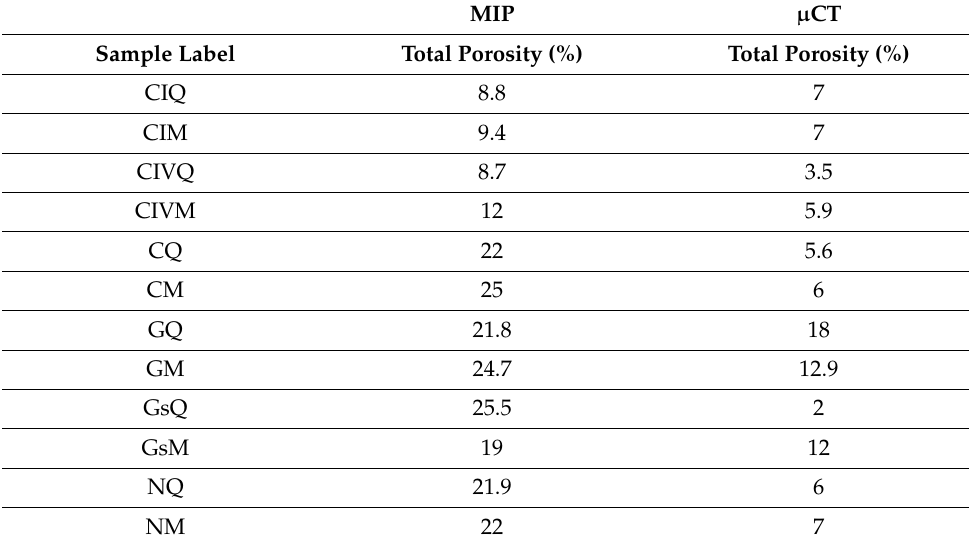
Table 4. Porosity results of MIP and X-ray µ